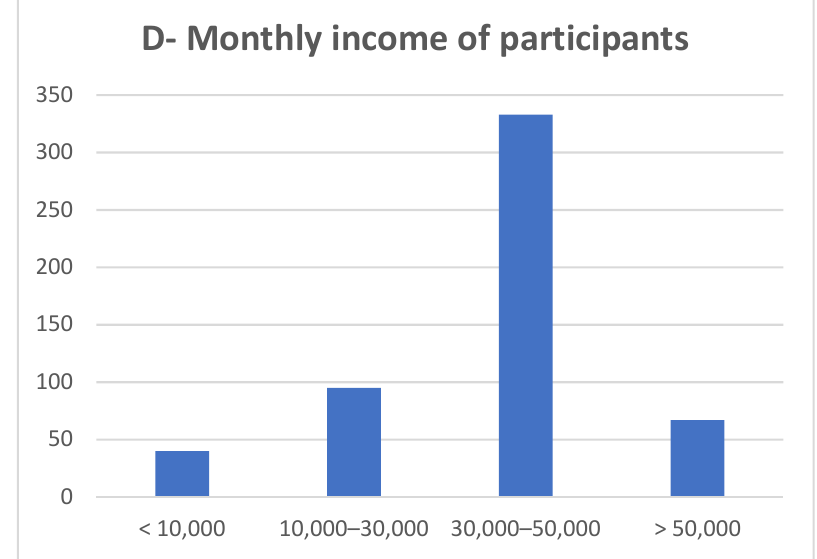
Figure 1. ( A – D ) Demographic information of respondents.